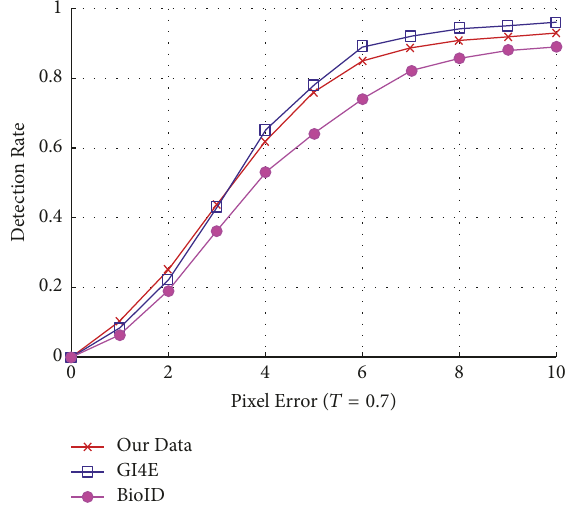
Figure 11: Eye center detection performance of our method on different